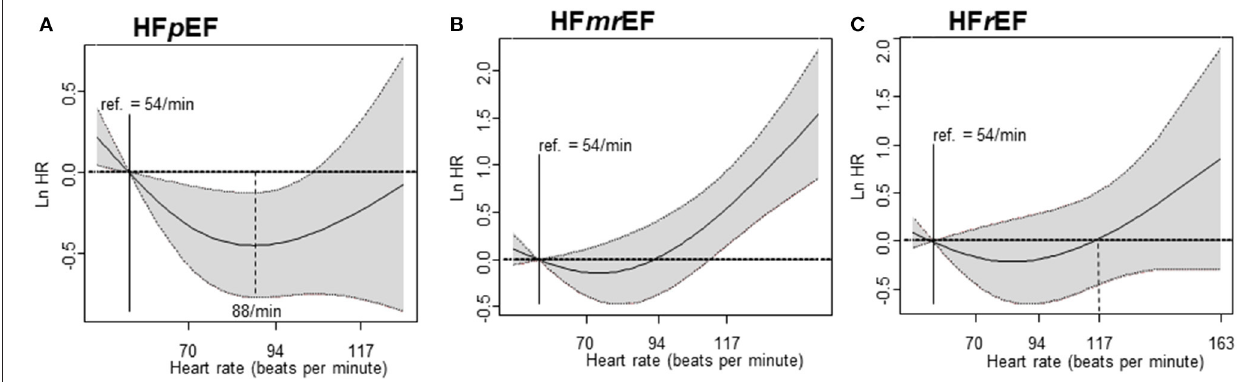
FIGURE 4 | Cox regression analysis – penalized spline. The primary endpoint according to heart failure in patients with HFpEF, HFmrEF, and HFrEF is shown. (A) Penalized spline regression in HFpEF, (B) Penalized spline regression in HFmrEF, and (C) Penalized spline regression in HFrEF. HFpEF, heart failure with preserved ejection fraction; HFmrEF, heart failure with mid-range ejection fraction; HFrEF, heart failure with reduced ejection fraction.